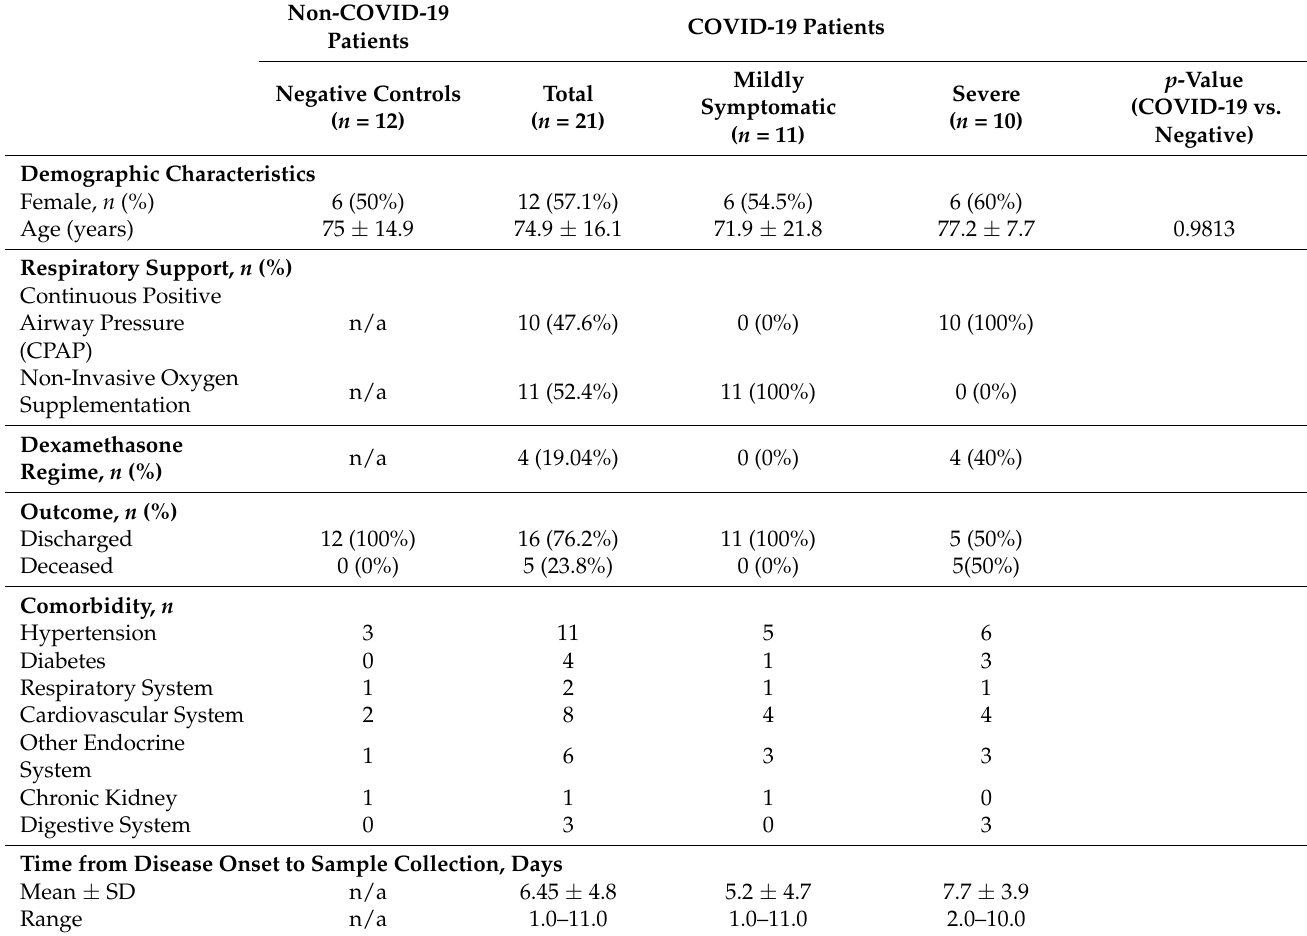
Table 1. Clinical data of the patients enrolled in the